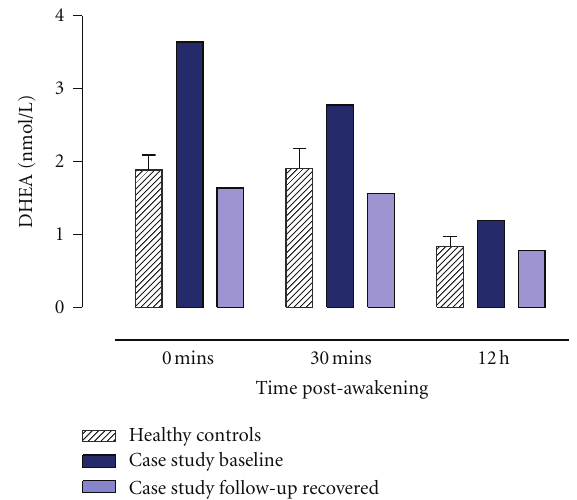
Figure 2: Mean ( ± SEM) salivary DHEA concentrations (nmol/l) after awakening and over the daytime period for the healthy control group ( n = 15) and case study Bella at baseline and when recovered at one year